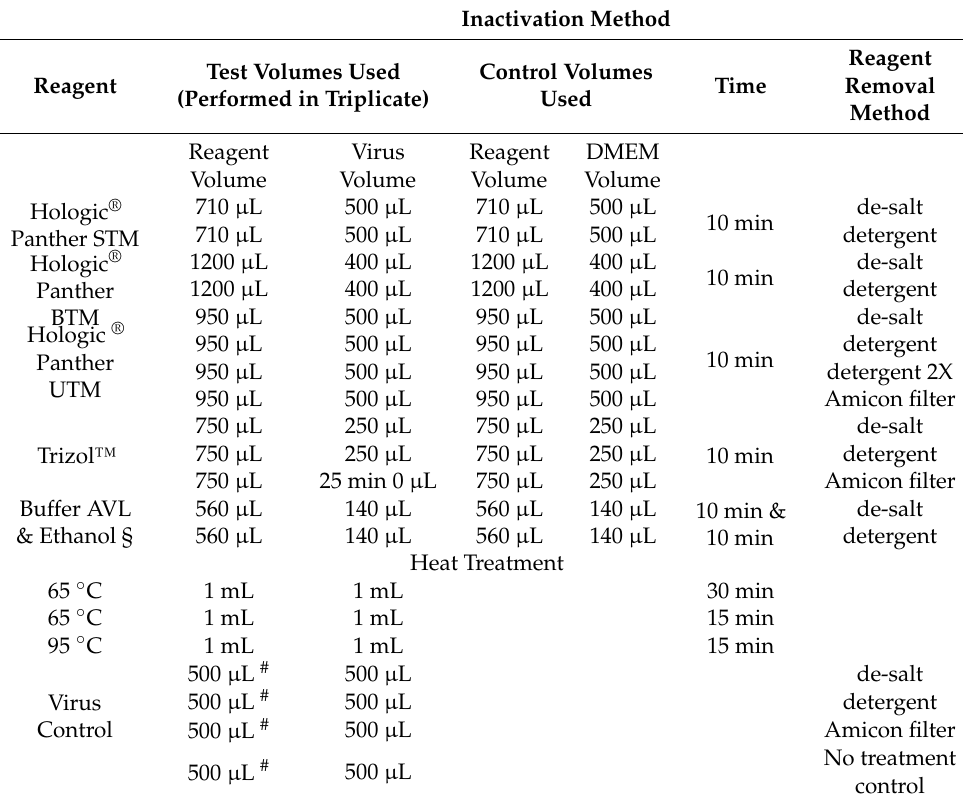
Table 1. Conditions of MPXV inactivation trials for 8 treatment methods and the reagent removal methods employed to enable verification of inactivation by plaque